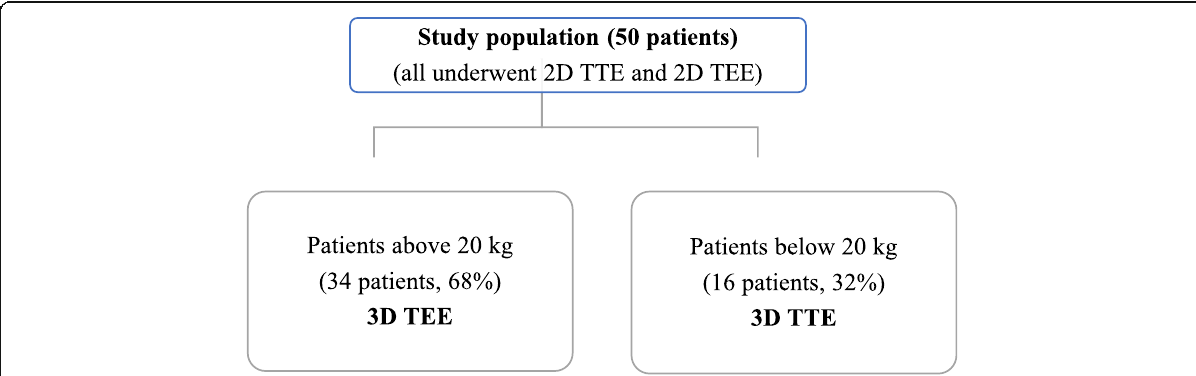
Fig. 3 Study population. (2D TTE: 2dimensional transthoracic echocardiography, 2D TEE: 2dimensional transesophageal echocardiography, 3D TTE: 3dimensional transthoracic echocardiography, 3D TEE: 3dimensional transesophageal echocardiography)